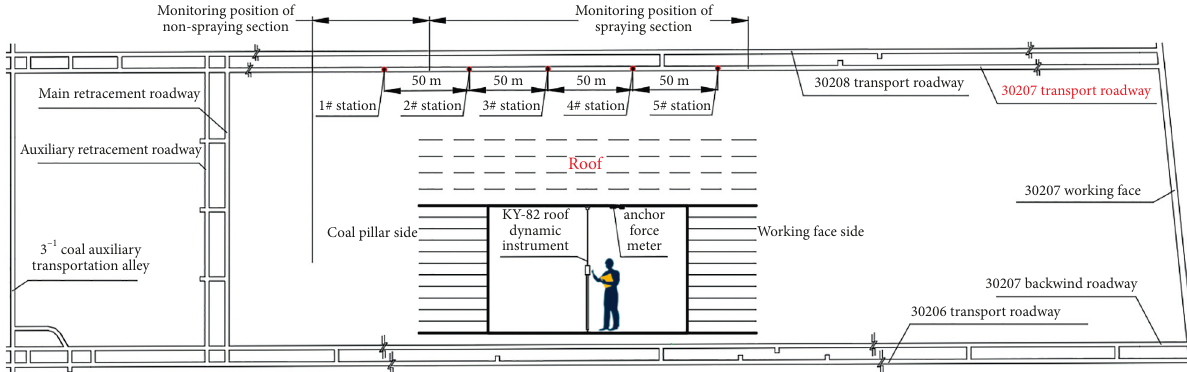
Figure 11: Location of roadway deformation